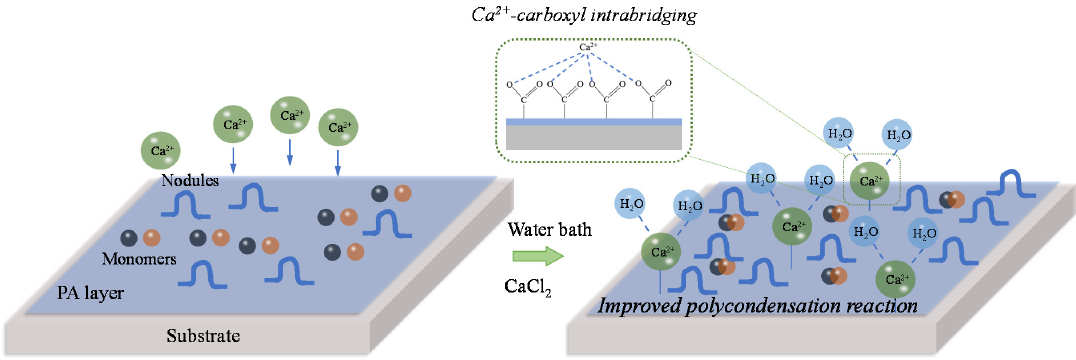
Figure 8. Schematic of mechanisms for Ca 2+ -carboxyl intra-bridging and modification during post-treatment.